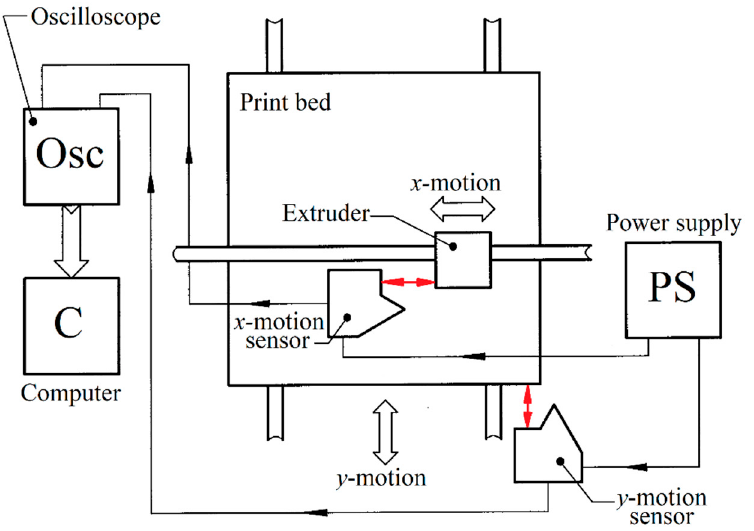
Figure 3. A scheme of the computer-assisted experimental setup.